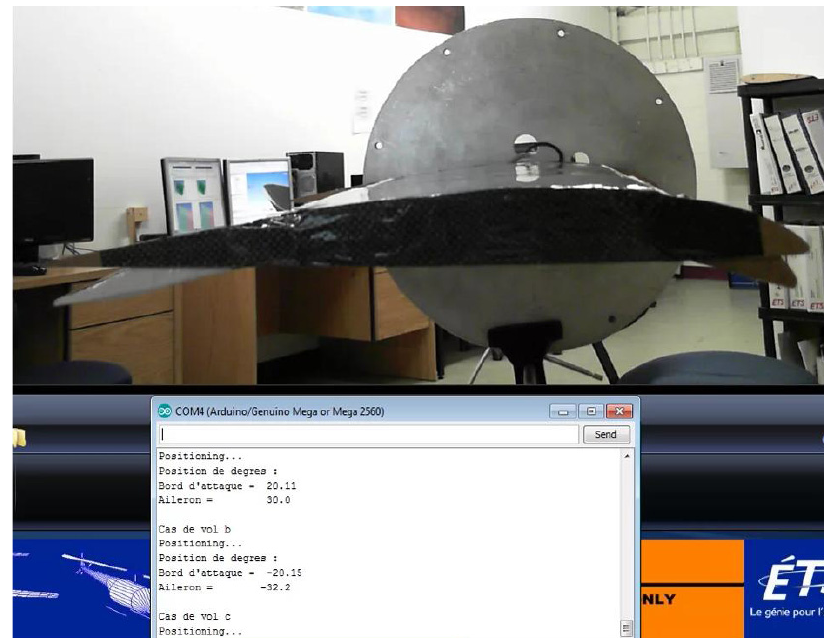
Figure 10. Bench tests of the wing prototype for the FEA results validation.